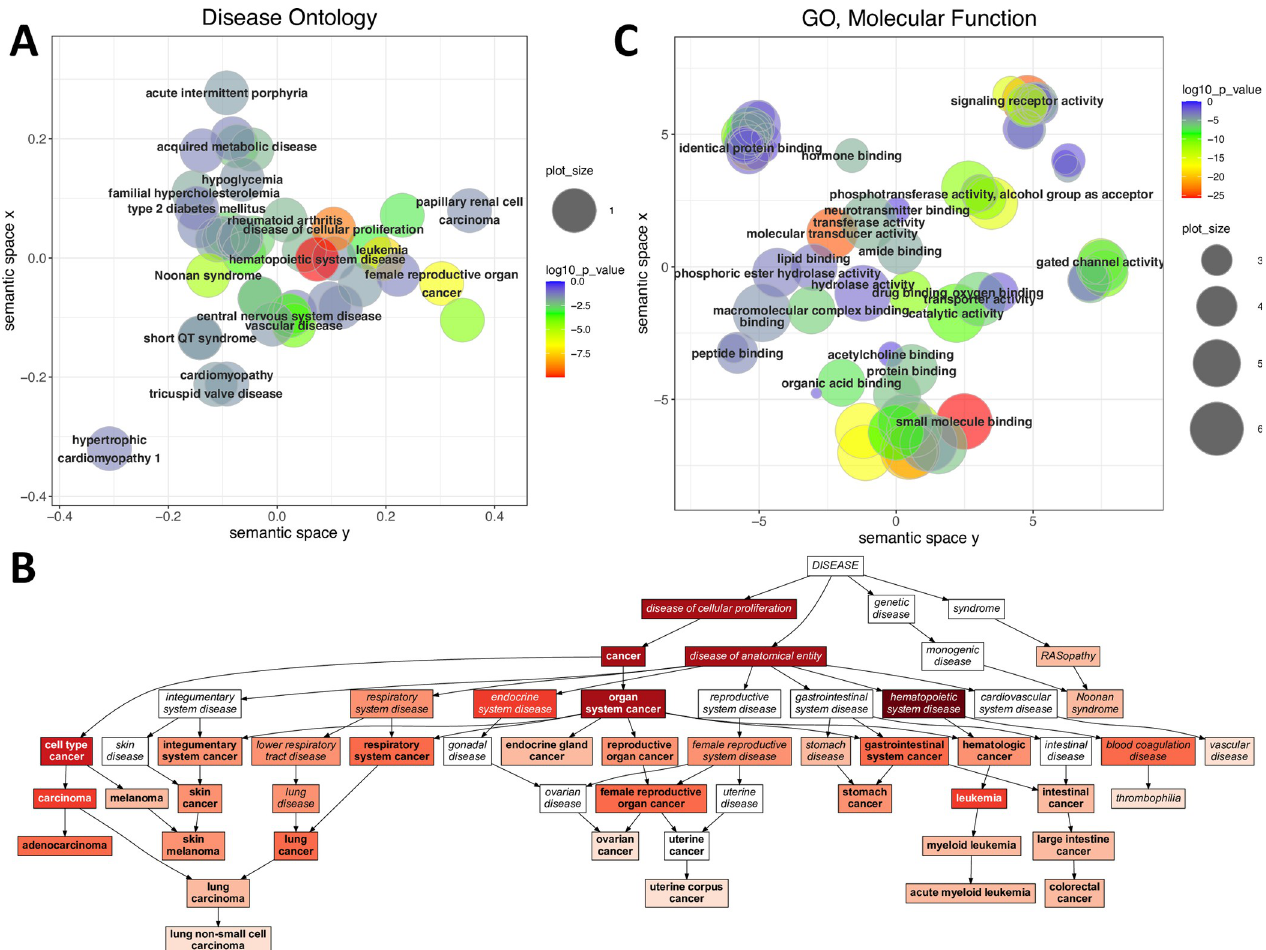
Fig 1. Enrichment of allosteric proteins in disease ontologies and gene ontologies. A) Summary of the disease ontology terms where allosteric proteins are significantly enriched. The terms were filtered for redundancy and plotted using their semantic similarities, the ones highlighted were selected manually from the filtered list of terms. Allostery is overrepresented in diverse diseases, which include many of the major disease types like cardiovascular diseases, metabolic diseases (e.g. hypercholesterolemia, diabetes) central nervous system diseases, and cancers. B) Graph of the disease ontology terms where allosteric proteins are most significantly enriched. The intensity of red corresponds to significance, only terms with p < 0.005 (Bonferroni-correction) are plotted. Allosteric proteins are most significantly associated with diseases of the hematopoietic system, cancers and vascular disease. C) GO analysis of significantly enriched Molecular Function terms. Related terms were grouped and visualized with REVIGO using their sematic similarity. The list of proteins in each term, and p-values are provided in S2 Table. The analysis shows that allosteric proteins are involved in diverse functions, and, unlike disease ontology terms, the enriched GO terms are not dominated by a few